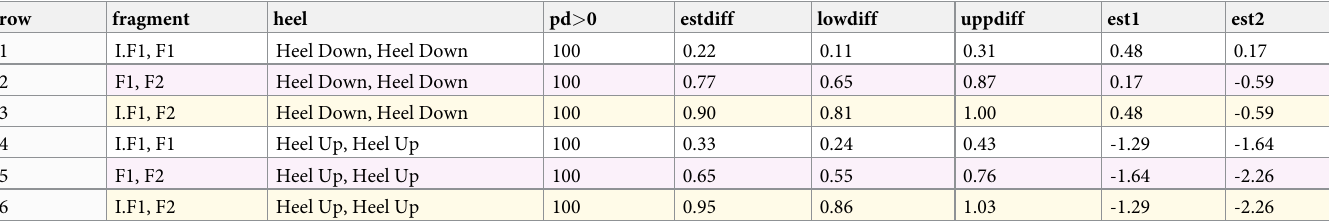
Table 4. Contrasts of